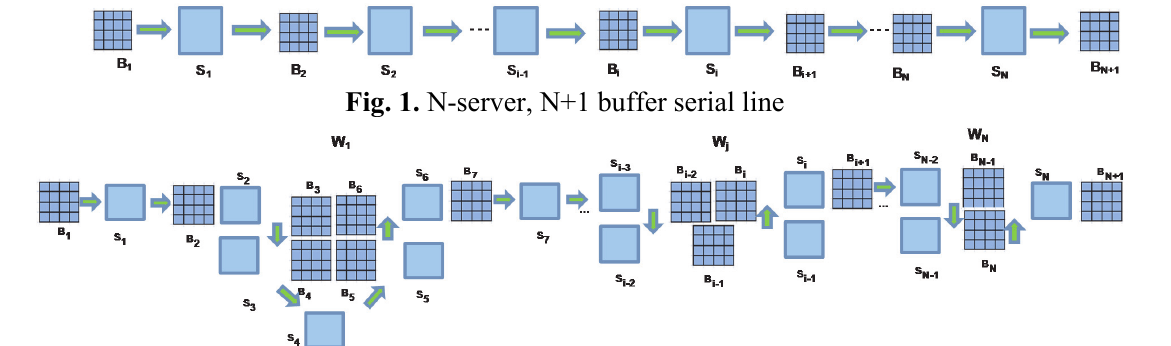
Fig. 2. Variable station work cells with one or more serial stations in between